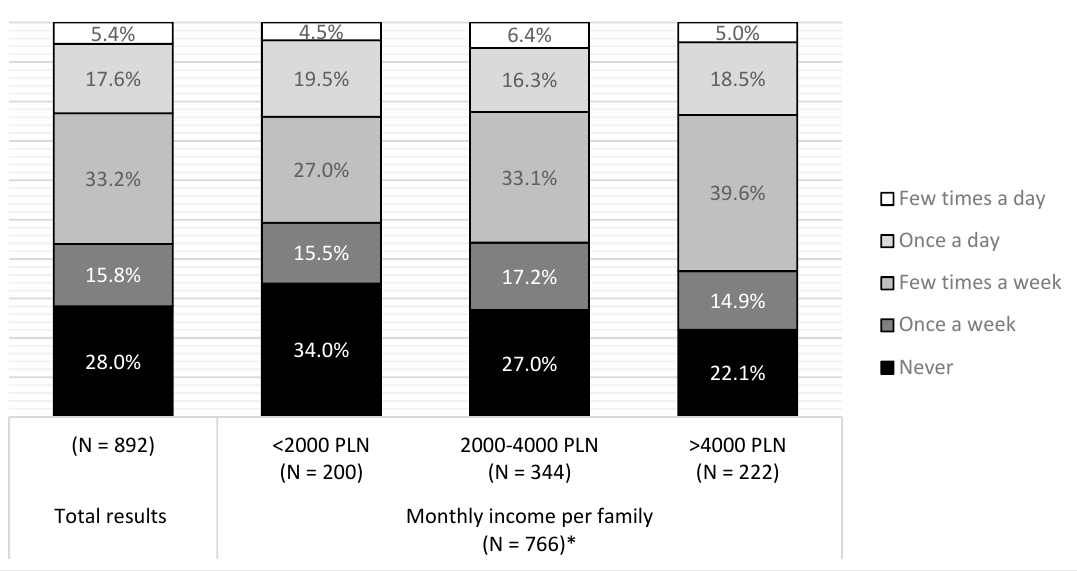
Figure 4. Frequency of whole grain consumption in the total surveyed population and sub-groups according to net monthly income per family. * 126 mothers did not declare monthly income per family. PLN: Polish z ł oty